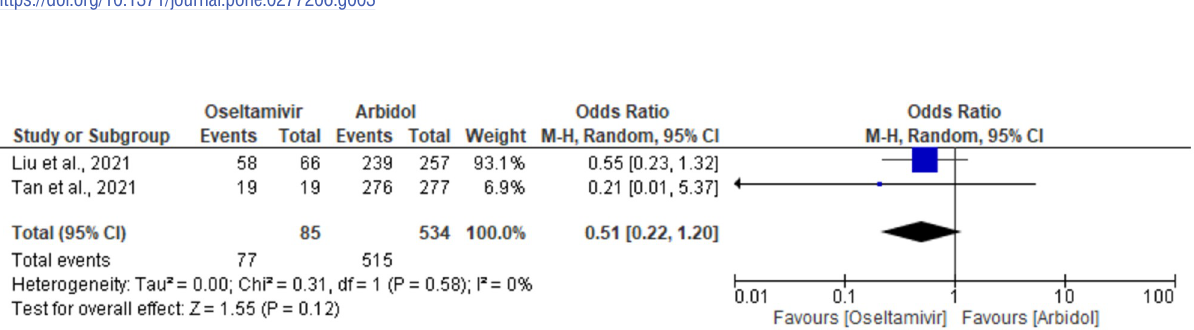
Fig 3. Forest plot. Shows pooled analysis for COVID-19 patients’ survival in the oseltamivir (monotherapy or combination) groups versus other drugs (alone or in combination) treatment.